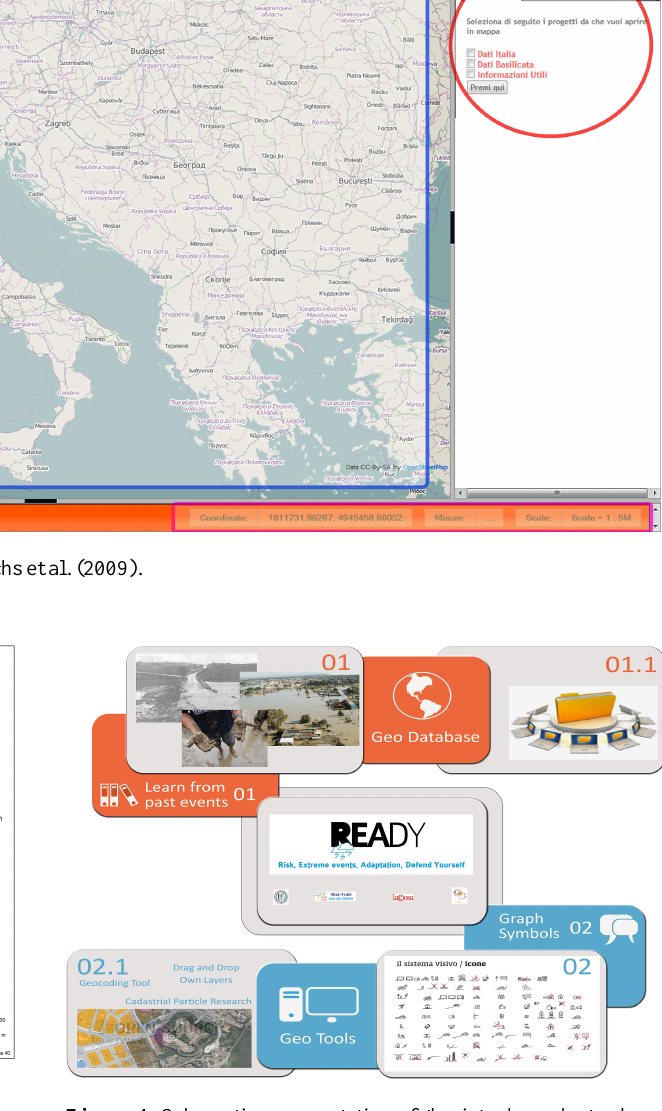
Figure 4. Schematic representation of the interdependent subsys- tems of